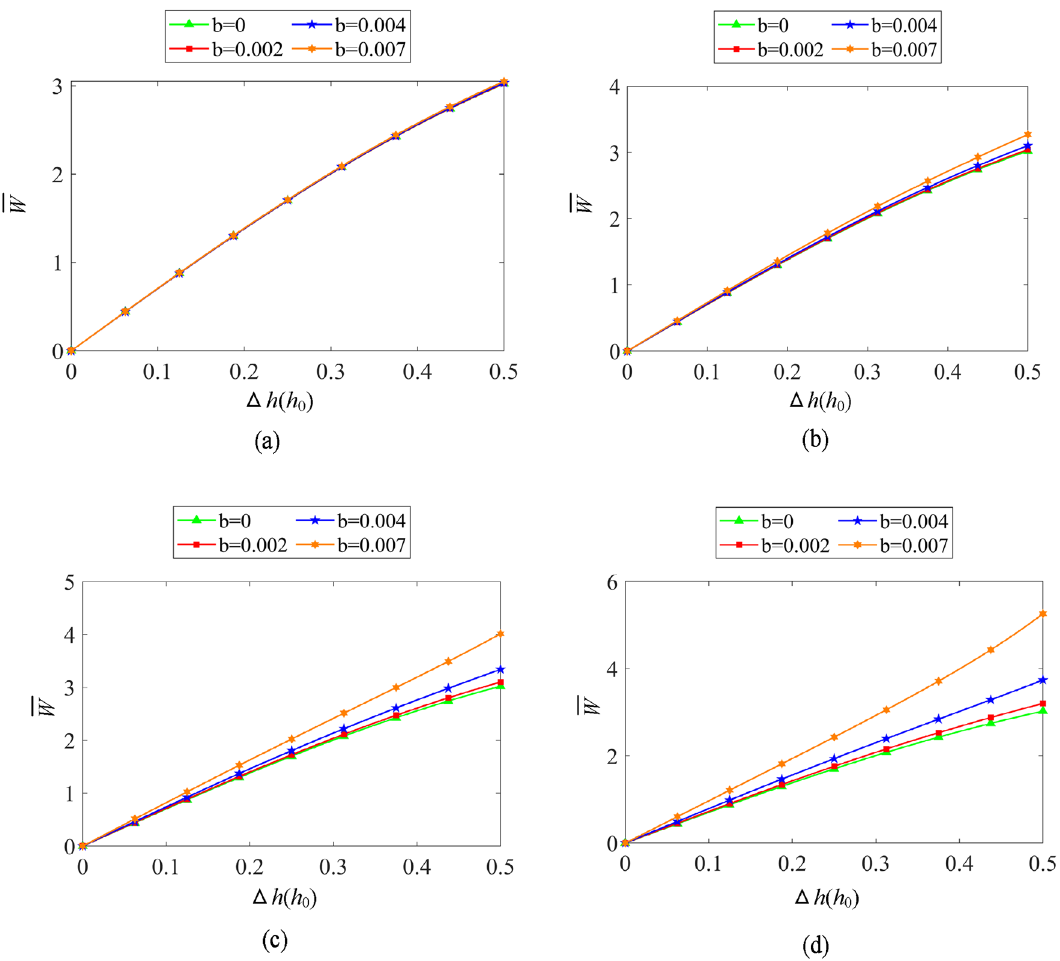
Figure 10. Influence of boundary slip on bearing capacity ( ω 2 = 0 rpm) ( a ) ω 1 = 1000 rpm, ( b ) ω 1 = 3000 rpm, ( c ) ω 1 = 6000 rpm, ( d ) ω 1 = 9000